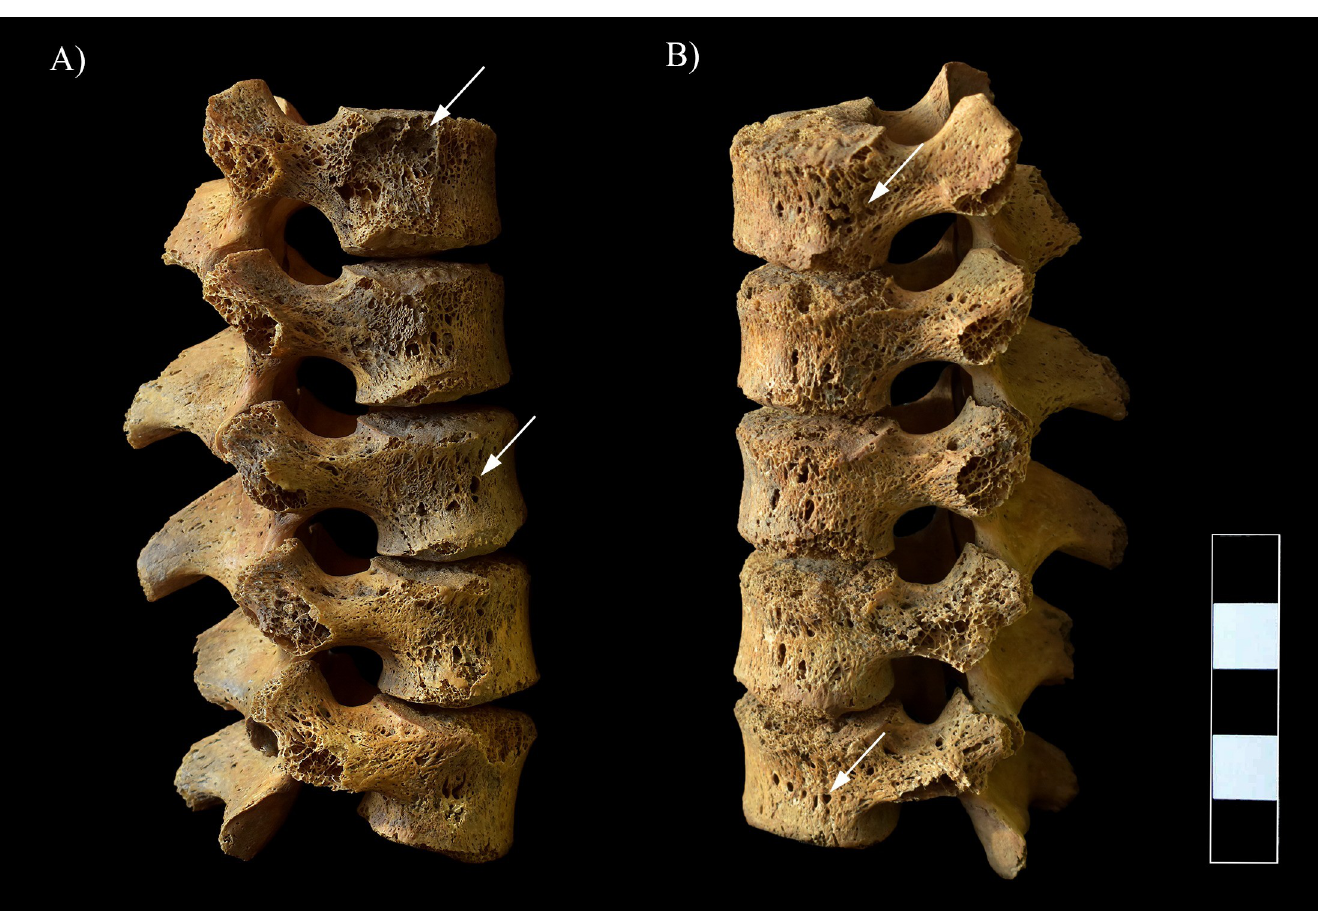
Fig 9. Multiple, well-circumscribed osteolytic lesions, cortical remodeling, and signs of hypervascularization in the L1–5 vertebrae (white arrows). A) Lateral view (right side) and B) Lateral view (left side).